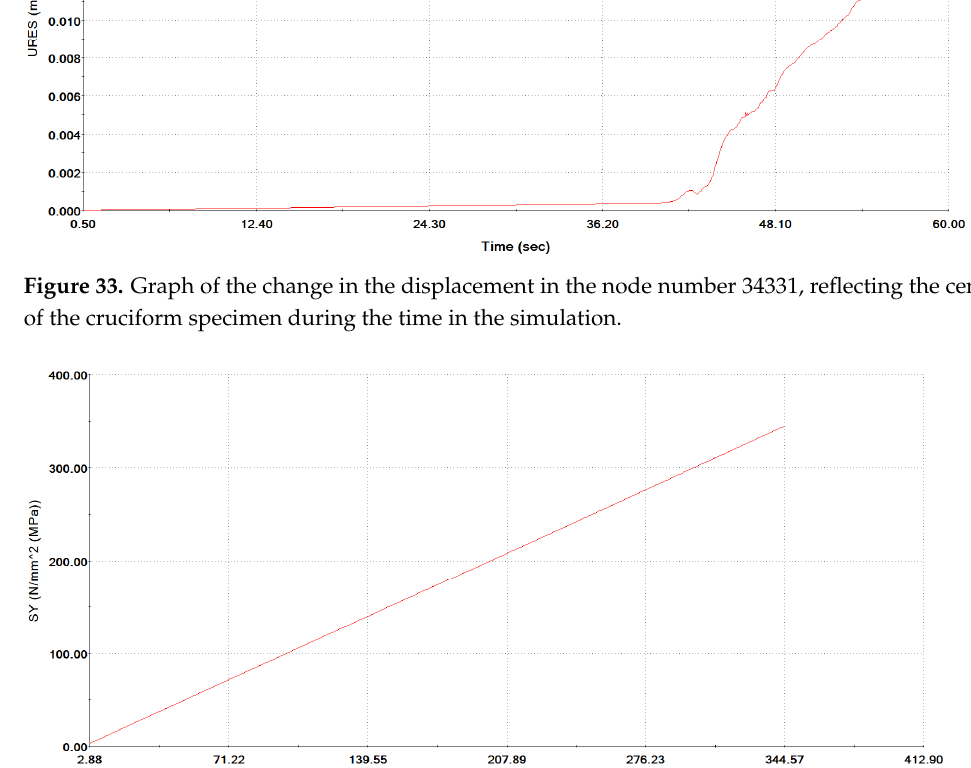
Figure 34. Figure 34. Graph of the characteristic which is based on σ y = σ y ( σ x ) stress, where SY is Figure 34. Graph of the characteristic which is based on 𝜎 (cid:3052) = 𝜎 (cid:3052) (𝜎 (cid:3051) ) stress, where SY is equal to